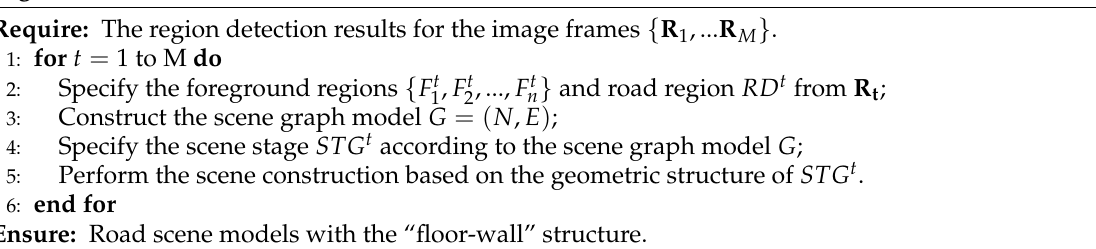
Algorithm 2 Road scene model